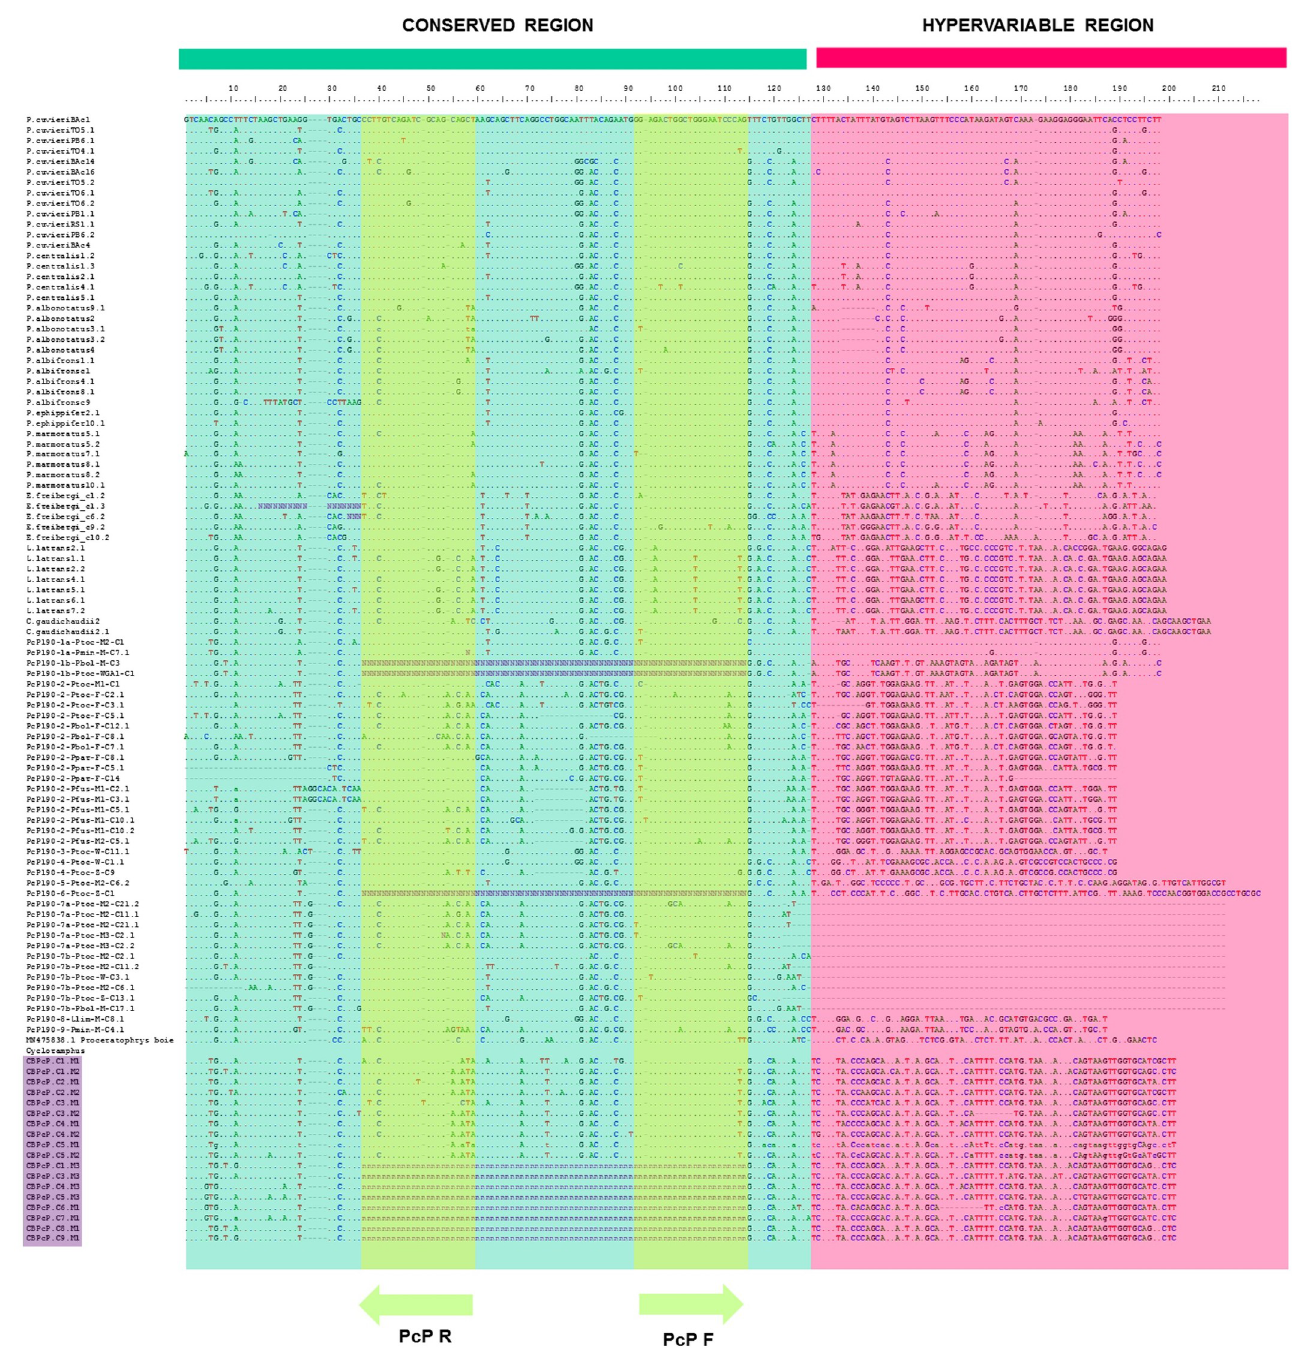
Fig 5. PcP190 satDNA alignment. Sequence alignment of the PcP190 satDNA clones obtained from the C . bolitoglossus genome (purple box) with the sequences from other anurans. Primer annealing sites are highlighted (green), as are conserved (blue) and hypervariable (pink) regions. The CR of the PcP190 of C . bolitoglossus was highly similar among the intragenomic monomers and in comparison with other anuran species ( > 77%) deposited in GenBank (S4 Table). As expected, the HR presented low nucleotide variation at the intragenomic level (94.86%) (S4 Table), but high levels of variation in compared with the HRs of the other anurans included in the